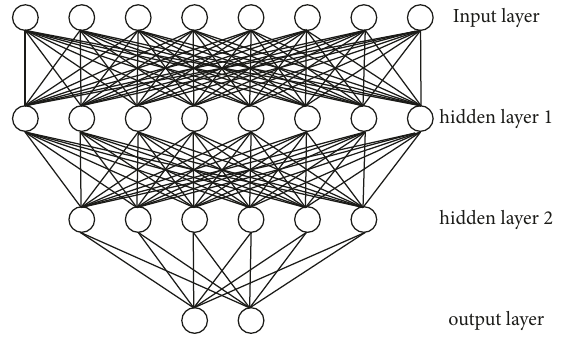
Figure 3: The basic structure of the path-planning strategy neural